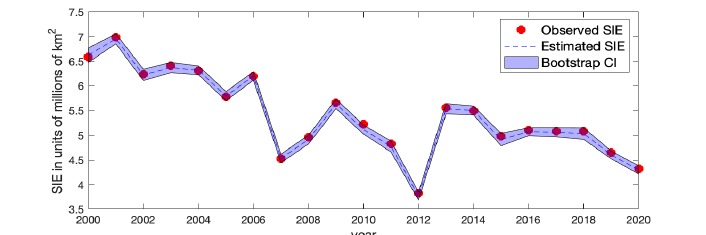
Figure A10. The observed Arctic SIE (red solid dot), the estimated Arctic SIE by Model-1c (blue dashed line), and the bootstrap pointwise 95% confidence interval of the Arctic SIE (shaded blue